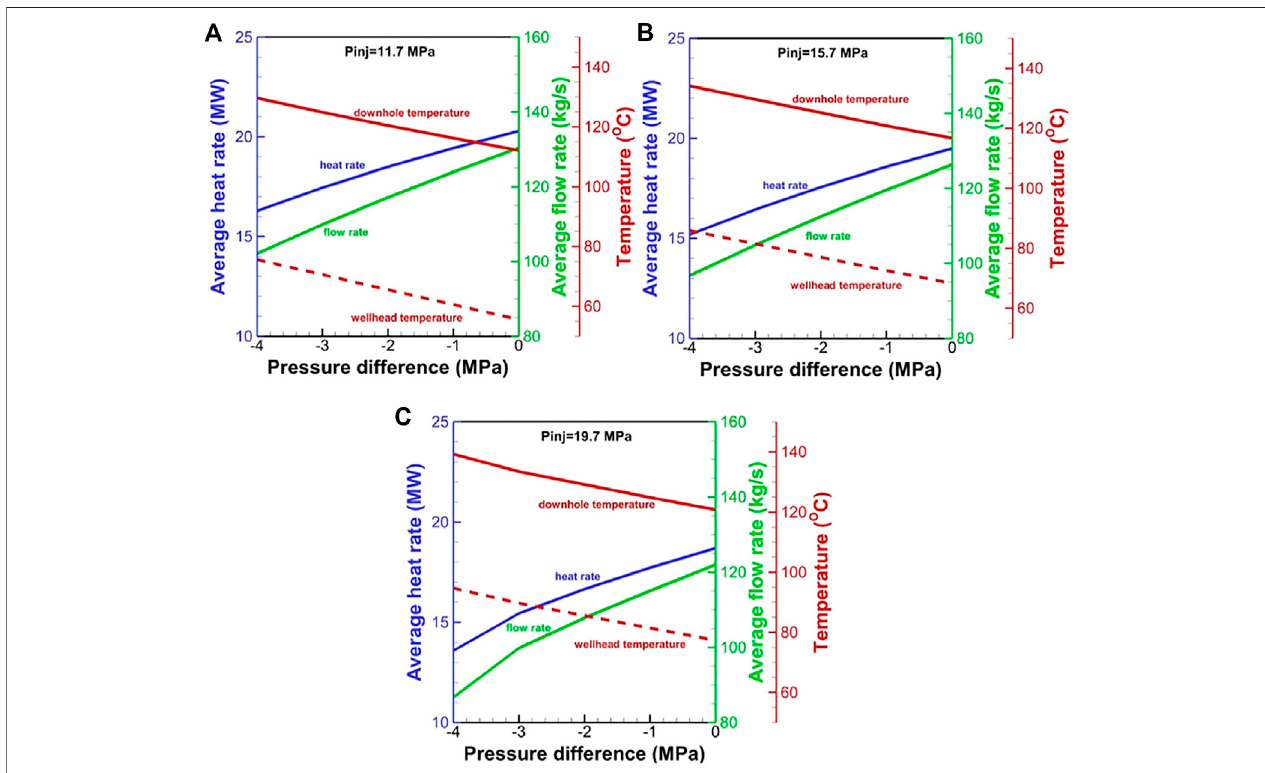
FIGURE 13 | Effect of pressure difference on performance for the CO 2 -based EGS at the wellhead pressure of (A) 11.7 MPa, (B) 15.7 MPa, and (C) 19.7 MPa in the injection well.